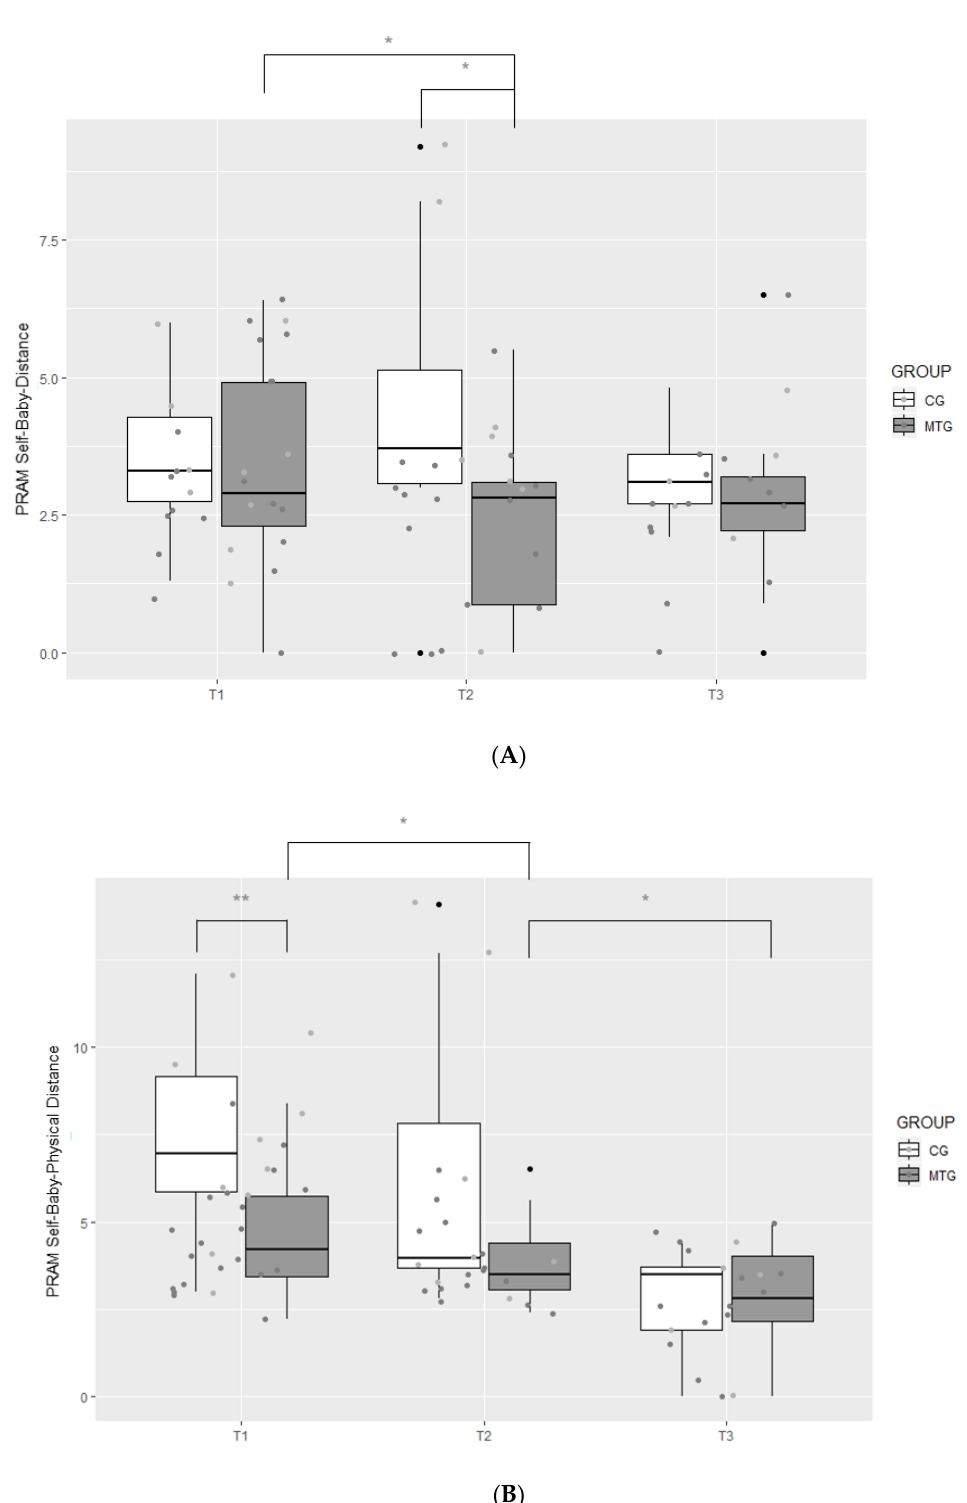
Figure 5. Boxplot of levels of the degree of Self – Baby Distance ( A ) and Self – Baby Physical Distance ( B ) in the music therapy group (MTG) and the control group (CG) measured at T1, T2, and T3 with the Pictorial Representation of Attachment Measure (PRAM), ** p < 0.01, * p < 0.025.